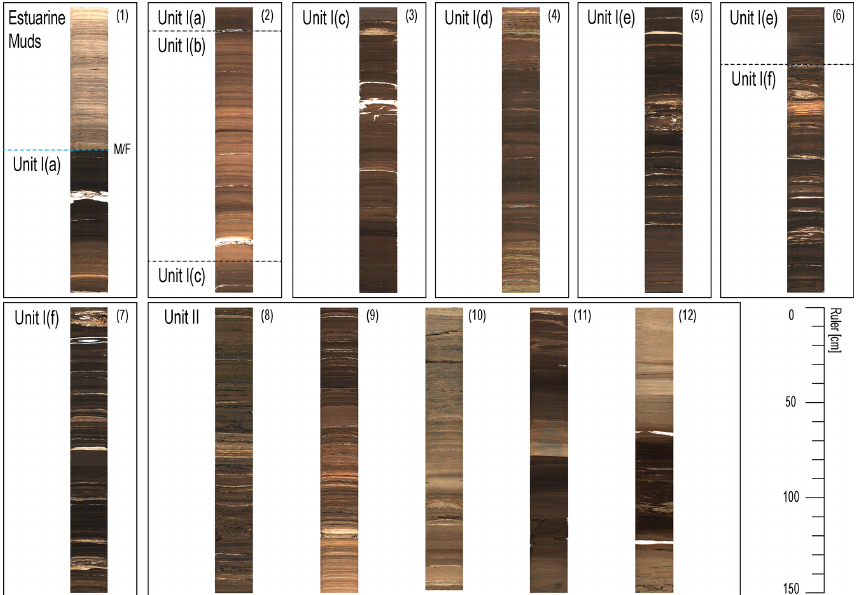
Figure 5. High-resolution core section images representative of the main facies units (Unit I and Unit II) as well as the six sub-units of Unit I (I(a) to I(e)). The depicted core images are ca. 1.5m long. An = andesitic tephra, B = basaltic tephra, Rh = rhyolitic tephra. (1) Transition from estuarine muds to Unit I(a); (2) transition from Unit I(a) over Unit I(b) to Unit I(c); (3) sediments of Unit I(c); (4) sediments of Unit I(d); (5) sediments of Unit I(e) with moderately developed laminations, occasional lighter and darker coloured bands; (6) transition from Unit I(e) to Unit (f) with coarser grained mass-waste deposits and their finer, orange-coloured gritty bands. (7) Sediments of Unit I(f) with coarse-grained (centimetre-scale) mass-waste deposits, fine, orange-coloured gritty bands, and centimetre-scale vivianite nodule bracketed by andesitic tephra (see top of core section); (8) well-developed laminations of Unit II; (9) well-developed laminations with decreasing quality downcore; (10) weathered basaltic detritus in Unit II; (11) subaqueous debris flow deposit Unit II; and (12) rhyolitic tephra ca. 2m above the core